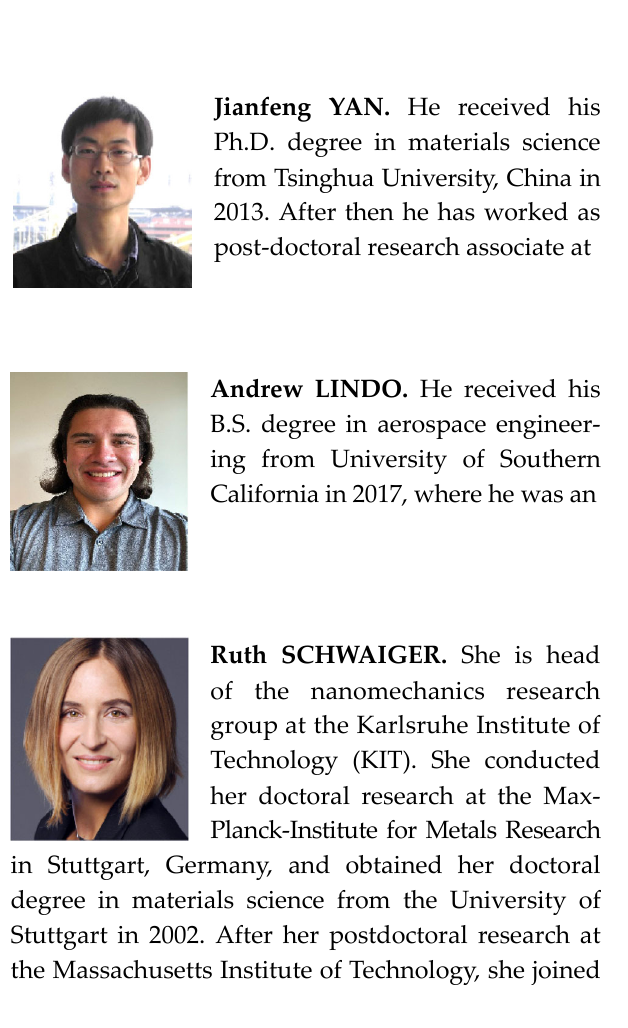
Binary Alloy Phase Diagrams . 2nd ed. Materials Park, OH: ASM International,